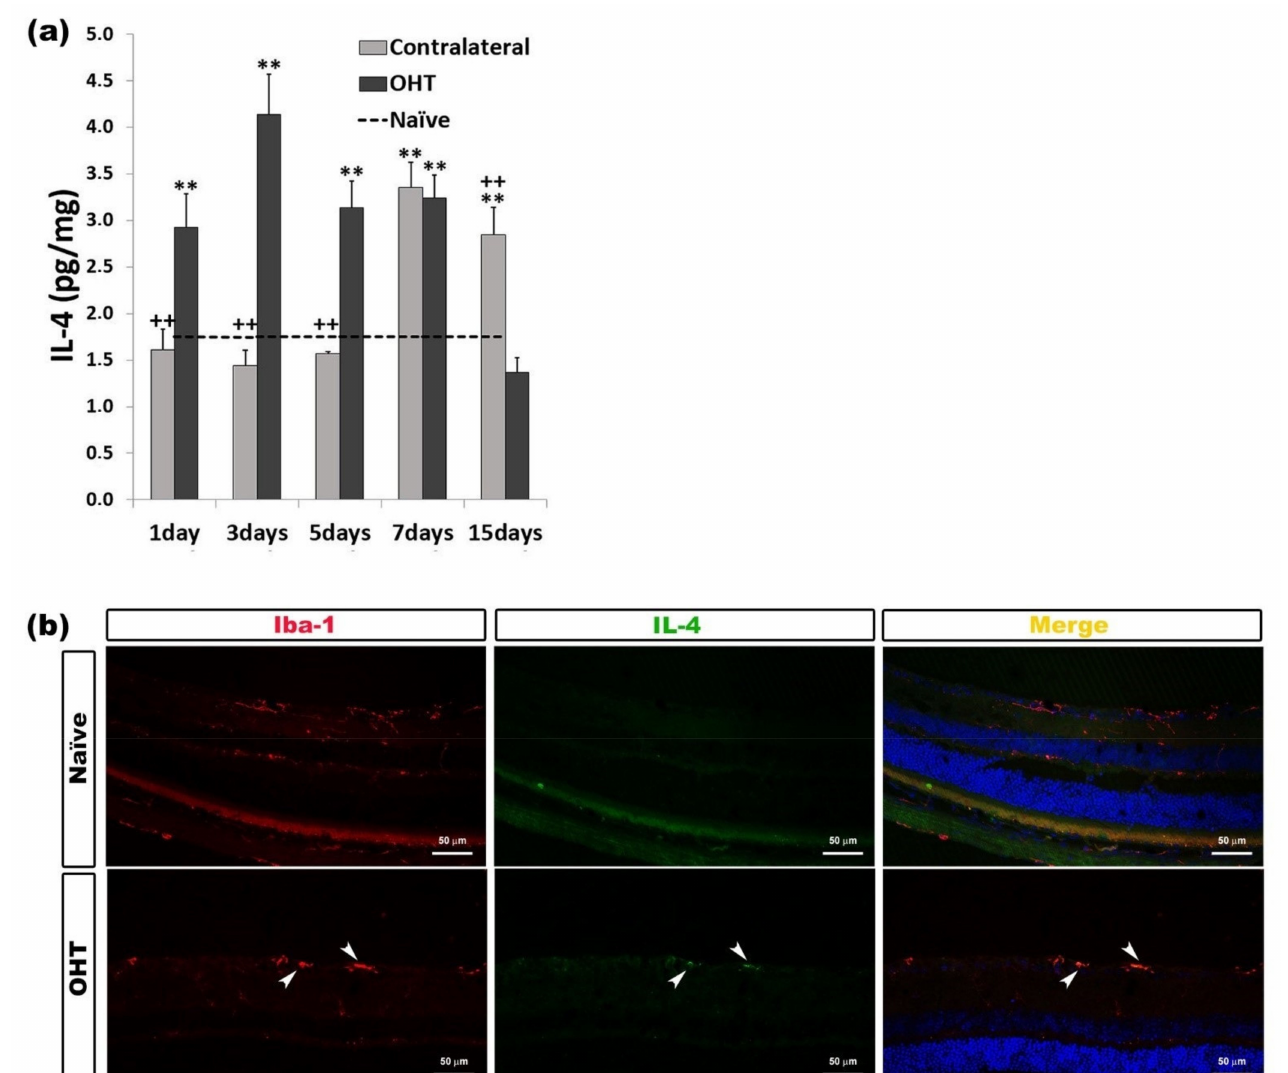
Figure 7. IL-4 levels at different times after laser-induced ocular hypertension (OHT). ( a ) Variation over time in the IL-4 levels in the multiplex assay. The histogram shows the mean levels ( ± SD) of IL-4 (pg/mg) at days 1, 3, 5, 7, and 15 after laser OHT induction, in ocular hypertension eyes (OHT) and in contralateral eyes. The dashed line indicates the mean levels in naïve eyes. Statistical significance indicators: ** p < 0.01 vs. naïve; ++ p < 0.01 vs. OHT. ( b ) Immunohistochemical study of IL-4 expression in OHT eyes three days after unilateral laser-induced OHT. Retinal sections were immunolabeled with antibodies to IL-4 (green) and Iba-1 (red). Merge (yellow). The arrowheads indicate the co-expression of Iba-1 and IL-4 in OHT eyes. Abbreviations: OHT (ocular hypertension); IL-4 (interleukin 4); Iba-1 (ionized calcium-binding adaptor molecule